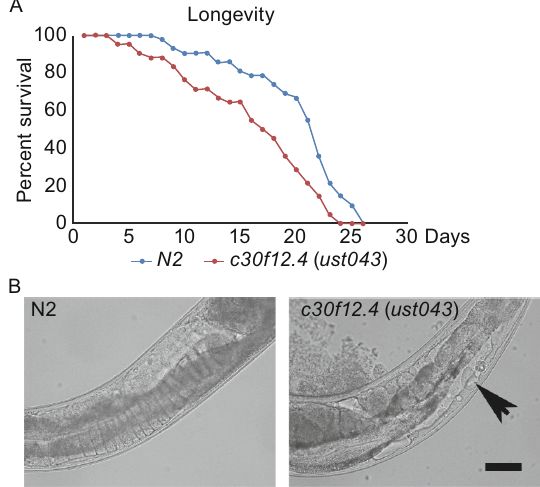
Figure 6. c30f12 .4 ( ust043 ) worms have reduced life span. (A) Adult life span of wild-type (blue line) and c30f12.4 ( ust043 ) (red line) worms. Sixty worms per trial, average of three trials. (B) Vacuole-like structures (black arrowhead), appear in c30f12.4 ( ust043 ) worm bodies towards the end of the repro- ductive period. Scale bar = 50 μ